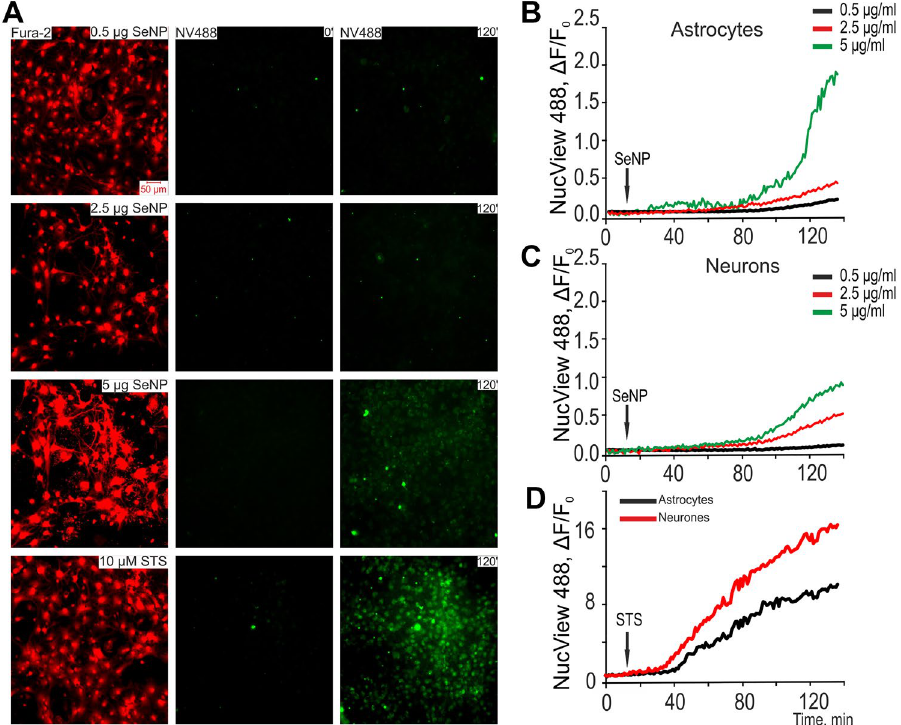
Figure 3. Effect of SeNPs on the activation of caspase-3-induced apoptosis in astrocytes and neurons of the cerebral cortex in vitro. ( A ) Images of cortical cell cultures loaded with a fluorogenic substrate of caspase-3, NucView-488, which were exposed to different concentrations of SeNPs and staurosporine (STS) within 120 min. Images of the cell culture in NucView-488 fluorescence detection channel before experiments (0 ′ ) and after 120-min SeNPs treatment are represented. Images correspond to the curves shown in panels ( B ), ( C ) and ( D ) (for STS). The appearance of green color in the micrograph means the appearance of NucView-488 fluorescence, which indicates the activation of Caspase-3 and apoptosis. ( B , C ) Hydrolysis of the fluorogenic substrate of caspase-3 (NucView-488) during a SeNPs treatment, indicating apoptosis induction in cortical astrocytes ( B ) and neurons ( C ). ( D ) Hydrolysis of the fluorogenic substrate of caspase-3 (NucView-488) during a 10 µM staurosporine treatment, indicating apoptosis induction in cortical astrocytes (black) and neurons (red). We used objective HCX PL APO 20.0 × 0.70 IMM UV, refraction index 1.52. Camera settings is 500 pixels × 500 pixels (Voxel Size 0.724 µm × 0.723 µm), binning 2 × 2, resolution 14 bits. There were 110 ± 87 cells in the field of view of the objective, as indicated by Fura-2 fluorescence in panel ( A ) (red, 380 nm